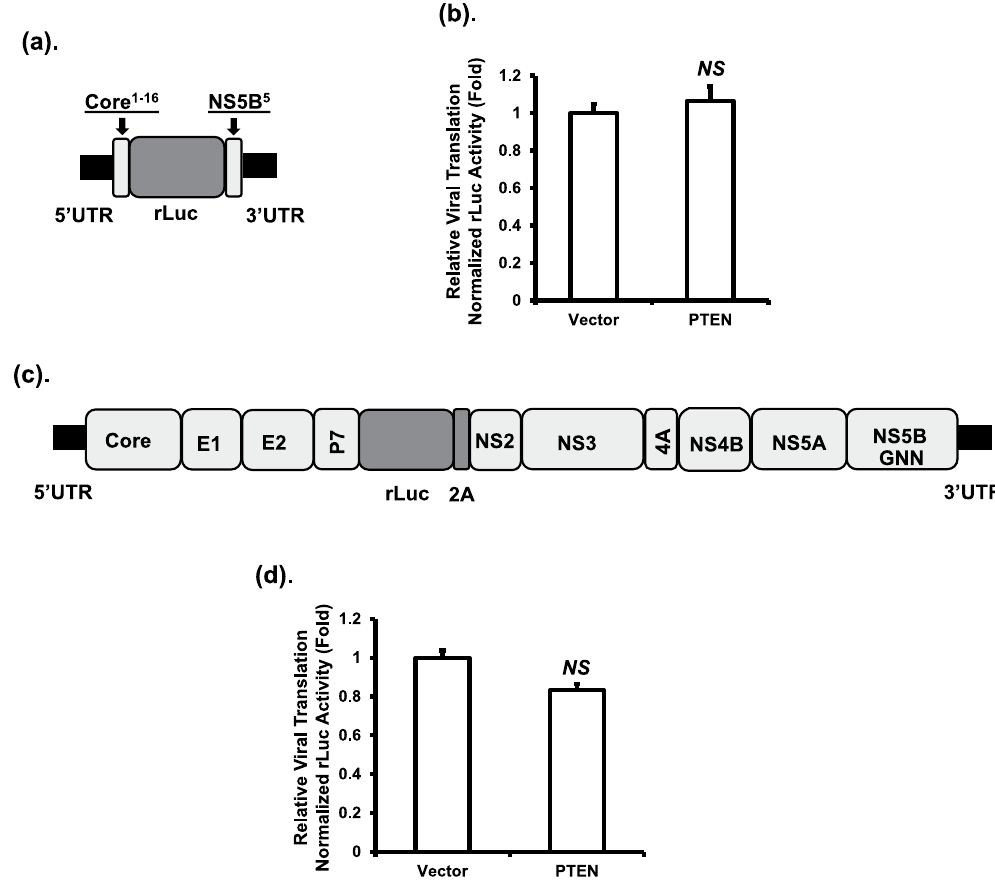
Figure 4. PTEN has no effect on HCV RNA translation. HCV translation was measured using either a monocistronic HCV-2a rLuc reporter ( a ) or a replication-deficient HCV-2a genomic RNA rLuc reporter ( c ). Huh-7 cells were co-transfected with the monocistronic translation rLuc reporter RNA ( b ) or the genomic RNA ( d ), and plasmid vector or PTEN-expressing plasmid. Luciferase assay was performed 24 hours after transfection. Data were expressed as fold changes relative to vector control; NS for not